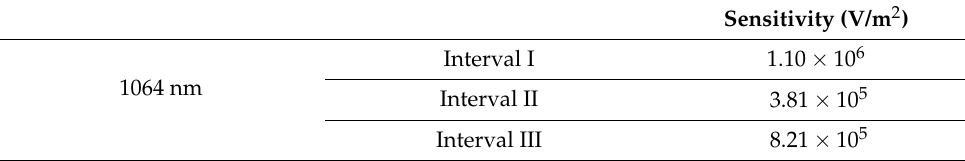
Table 2. Sensor sensitivity for λ = 1064